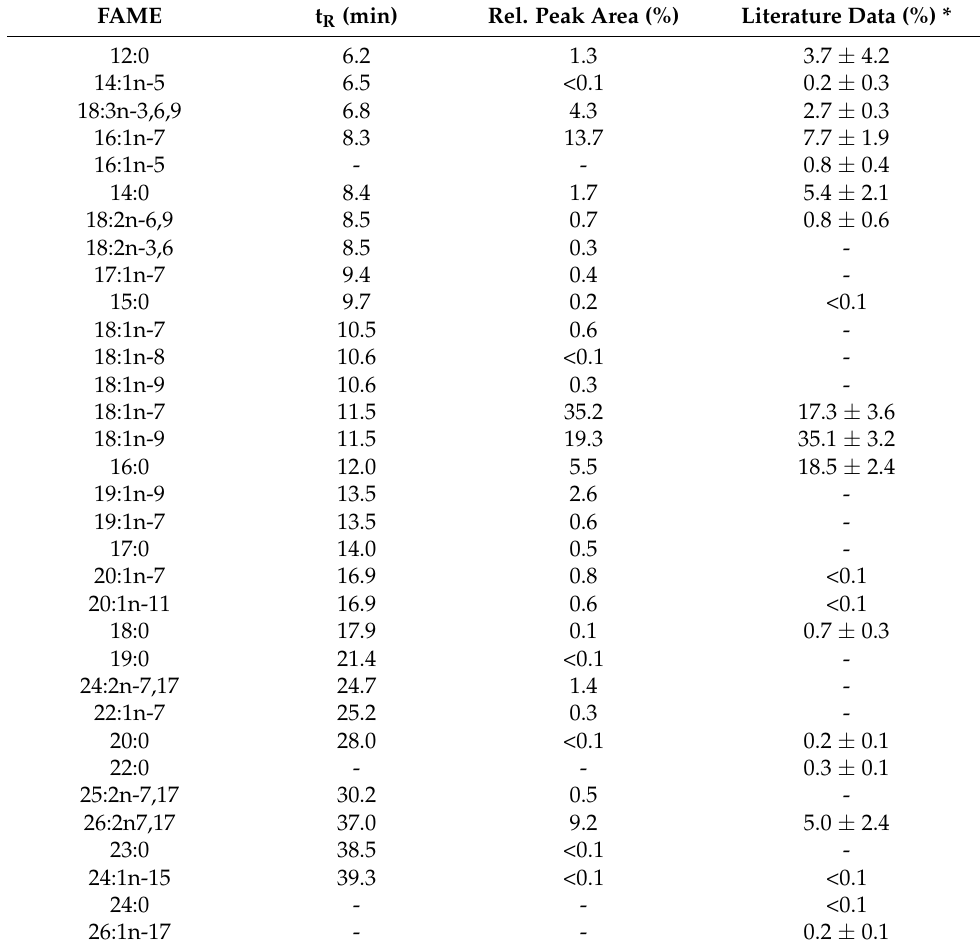
Table 2. FAMEs identified in TG fraction of B. pratorum fat body